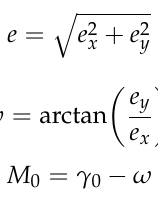
Table 3. Estimable ephemeris parameters for LEO satellites. Number of